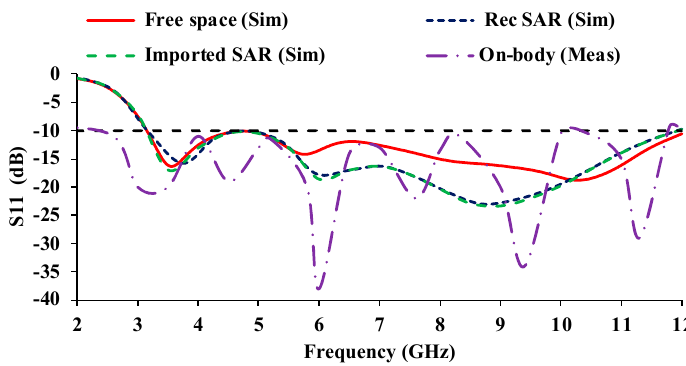
Figure 24. Reflection coefficient of SAR analysis of a MIMO prototype.